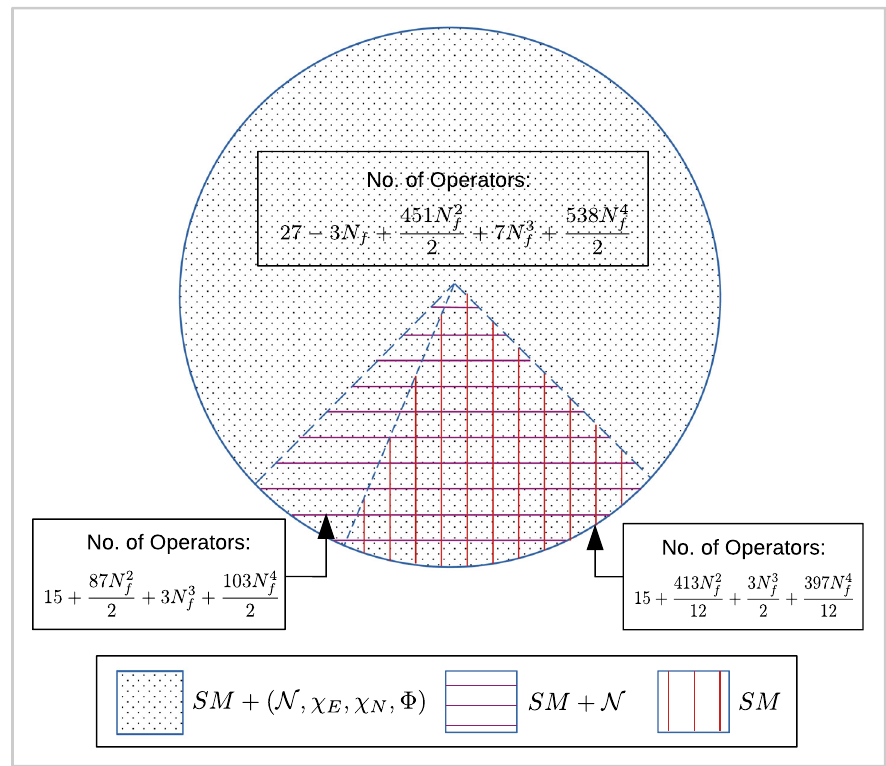
Fig. 11 Pie-chart showing number of operators including their conjugates for 3 distinct